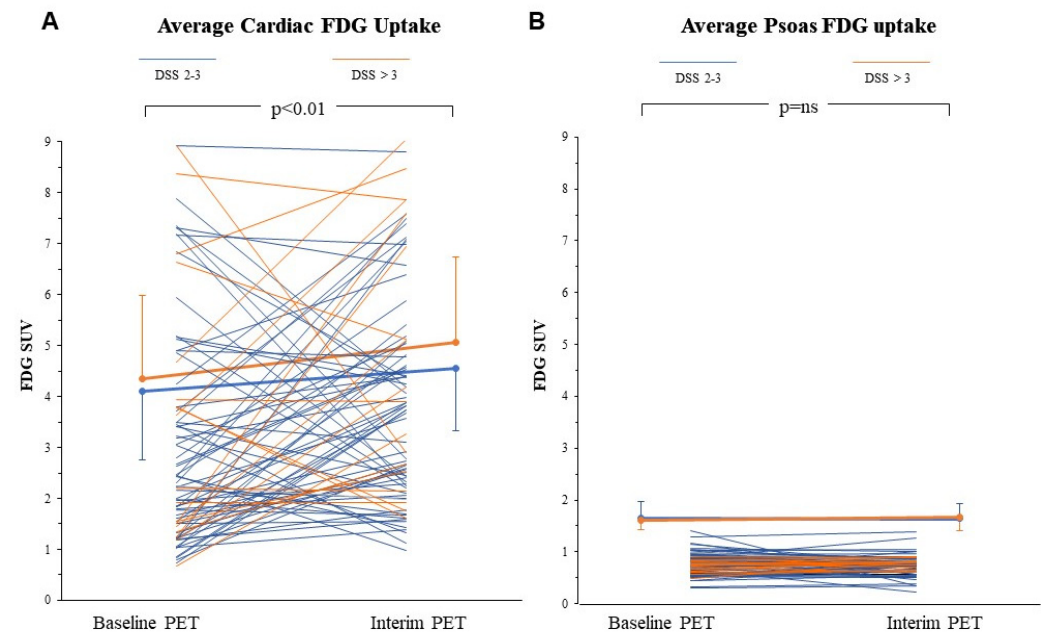
Figure 1. Individual and average cardiac (thick lines) SUV ( A ) increased to a comparable extent from baseline to interim PET in patients with acceptable response to ABVD regimen (DSS 2–3, blue lines), and in those in which therapy scheme was escalated to BEACOOP because of a DSS > 3 (orange line). This systematic response was not observed in psoas muscles ( B ) also because of the markedly lower SUV of this tissue. ns = not significant.